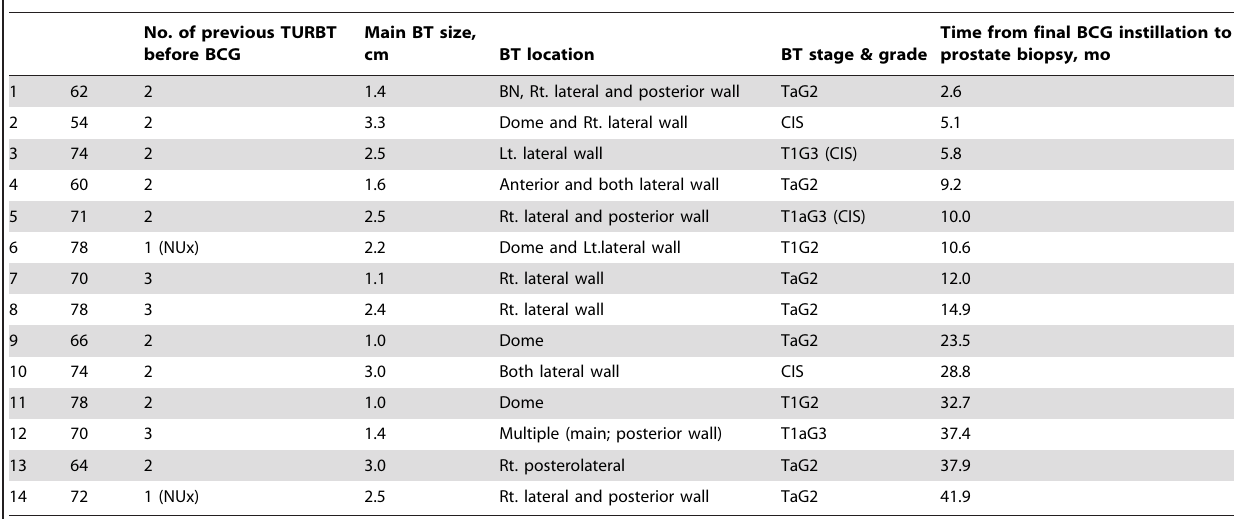
Table 2. Characteristics of Previous TURBT and BT in Patients Diagnosed with Prostate Cancer after BCG Instillation.